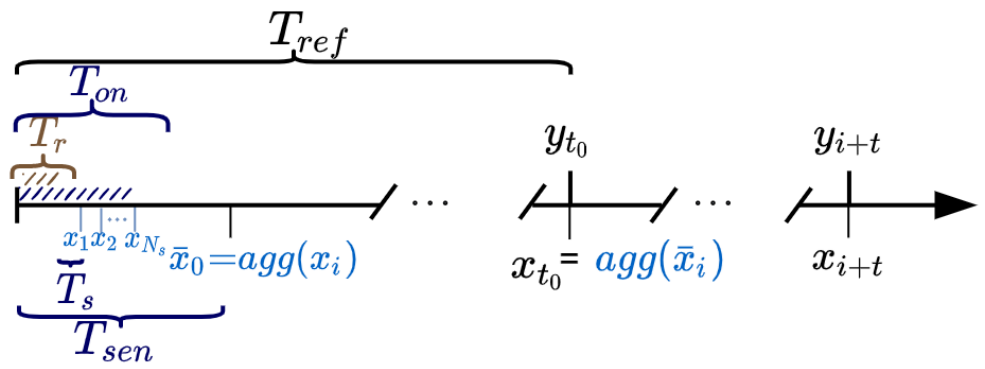
Figure 3. Sensor sampling scheme used throughout the article. x i are the sensor measurements while y i are the reference data measurements. Every T sen , the sensor is sampled by waiting for the sensor response time T r and collecting the N s samples to be aggregated. These T sen samples can be further aggregated into T ref to synchronize them with the reference